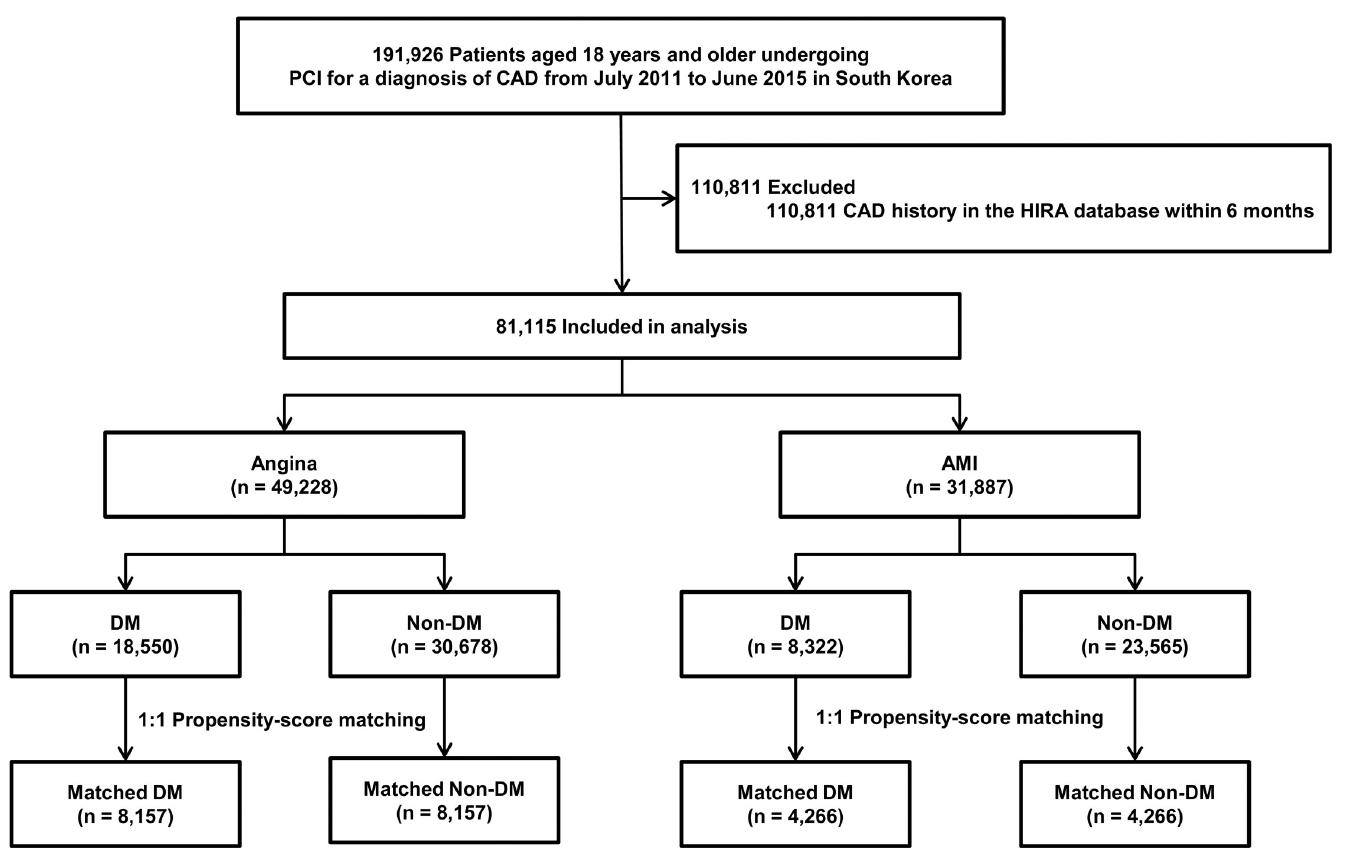
Fig 1. Overview of the study population. CAD = coronary artery disease; DM = diabetes mellitus; HIRA = Health Insurance Review & Assessment Service; AMI = acute myocardial infarction; PCI = percutaneous coronary intervention.